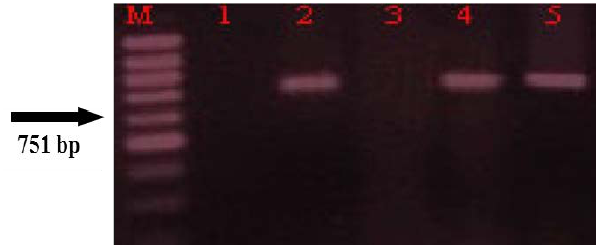
Fig. 3. PCR detection of P. indica in DNA of cucumber roots with the designed specific primer pair of an annotated sequence of the β-tubulin gene. ‘M’ denotes a 100 bp ladder DNA size standard (AppliChem, Darmstadt, Germany). Lanes 1-5 show PCR results from different DNA templates, under of P. indica (positive control); lane 3: DNA from root of non-